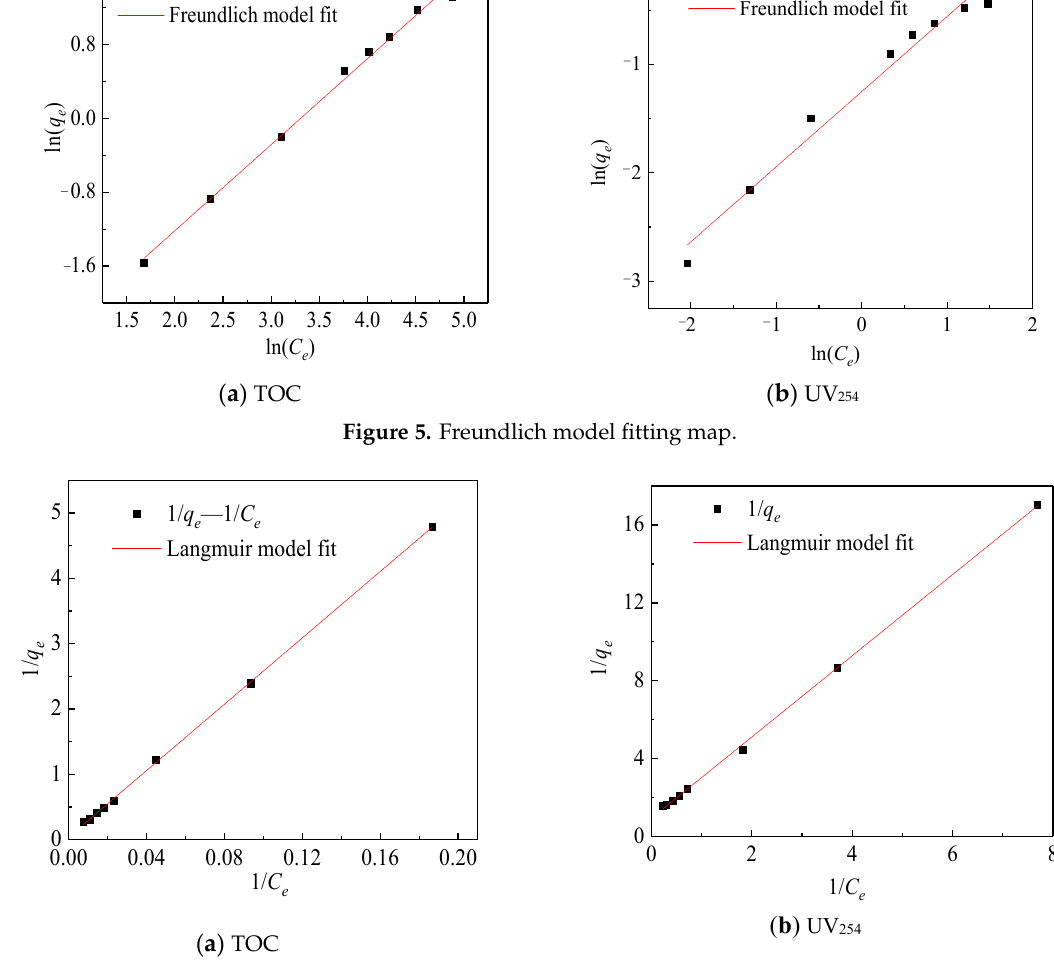
Figure 6. Langmuir model fit Figure 6 . Langmuir model fit map. Table 3 . Isotherm constant fittings for TOC 、 UV 254 and Chromaticity adsorption with Langmuir and Freundlich models.